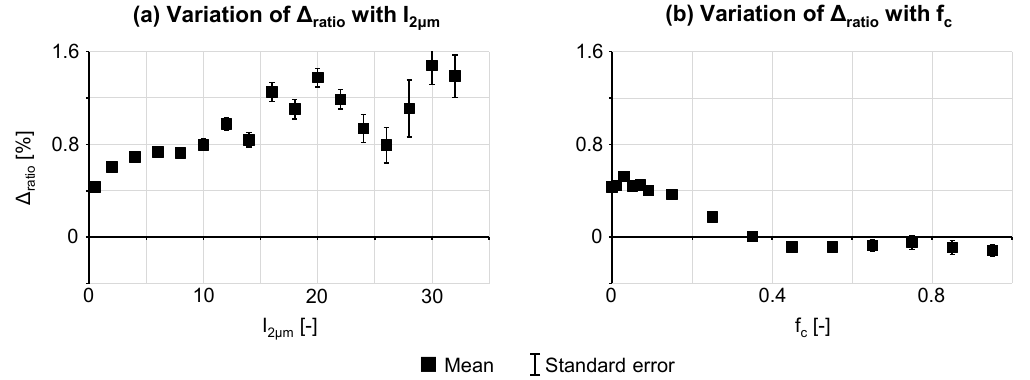
Figure 3. Variation of the relative di ff erence in the ratio component between GOSAT and TCCON ( ∆ ratio ) according to ( a ) the normalized 2 µ m band radiance (I 2 µ m ) and ( b ) the cloud fraction (f c ,). Only data with f c = 0 were used for ( a ), and only data with I 2 µ m ≤ 1 and NDSI ≤ 0.4 were used for ( b